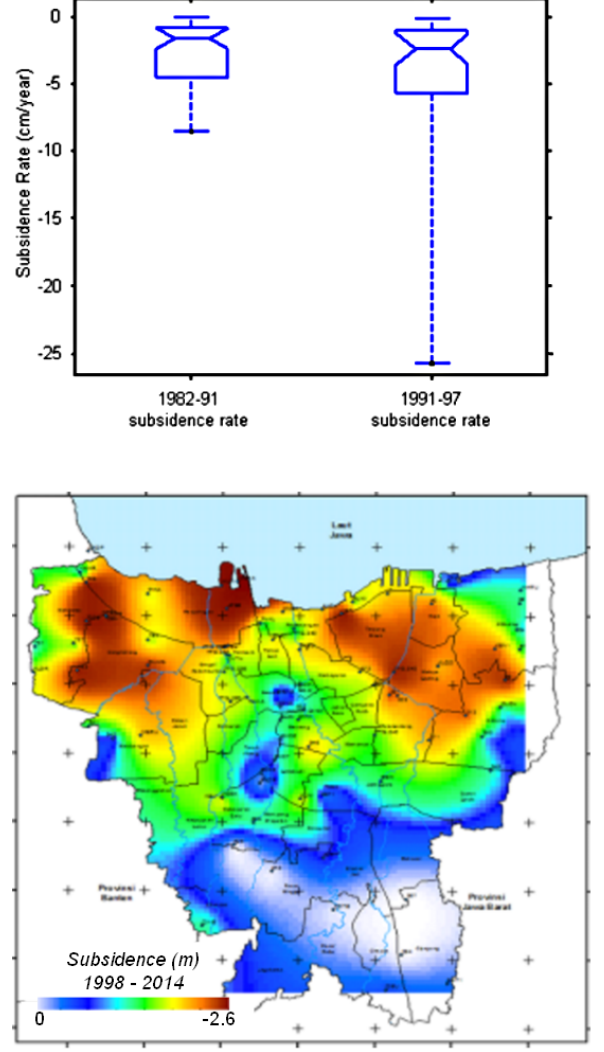
Figure 3. Temporal and spatial variations of land subsidence in Jakarta: (top) Box-and-Whisker plots of land subsidence rates as de- rived by leveling surveys from 1982 to 1997 (Abidin et al., 2011); (bottom) land subsidence magnitudes as derived by GPS surveys from 1998 to 2014 (Wibowo, 2014).